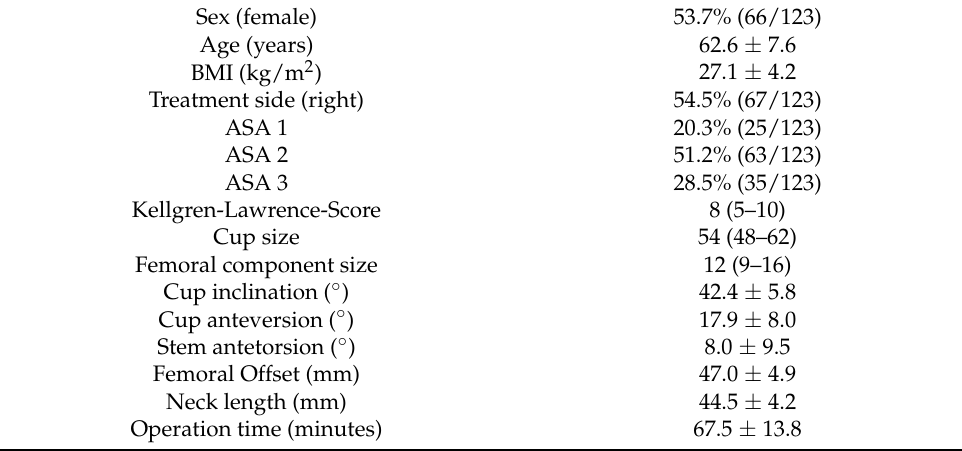
Table 1. Anthropometric and operative characteristics of the study